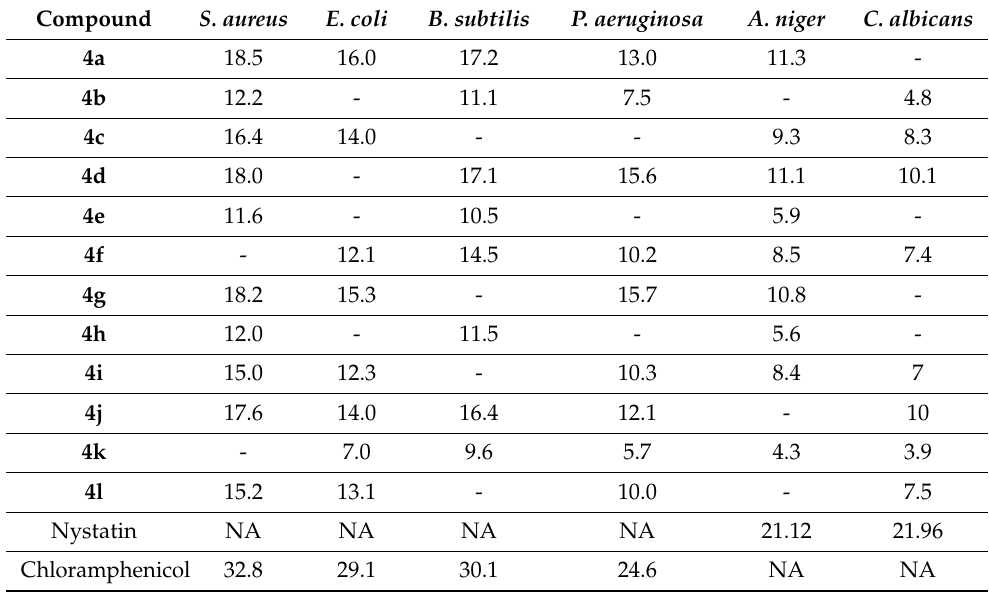
Table 2. Antimicrobial screening of synthesized compounds 4a–l . Compound